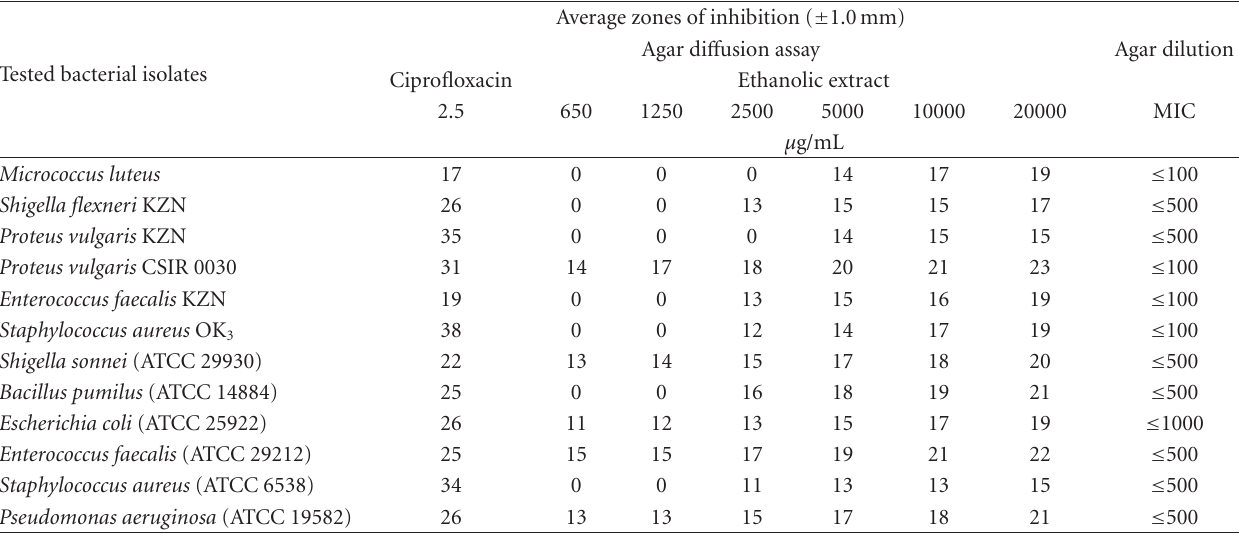
Table 1: Results of agar di ff usion assays to determine the antibacterial activity of the crude ethanolic extract of E. ca ff ra.